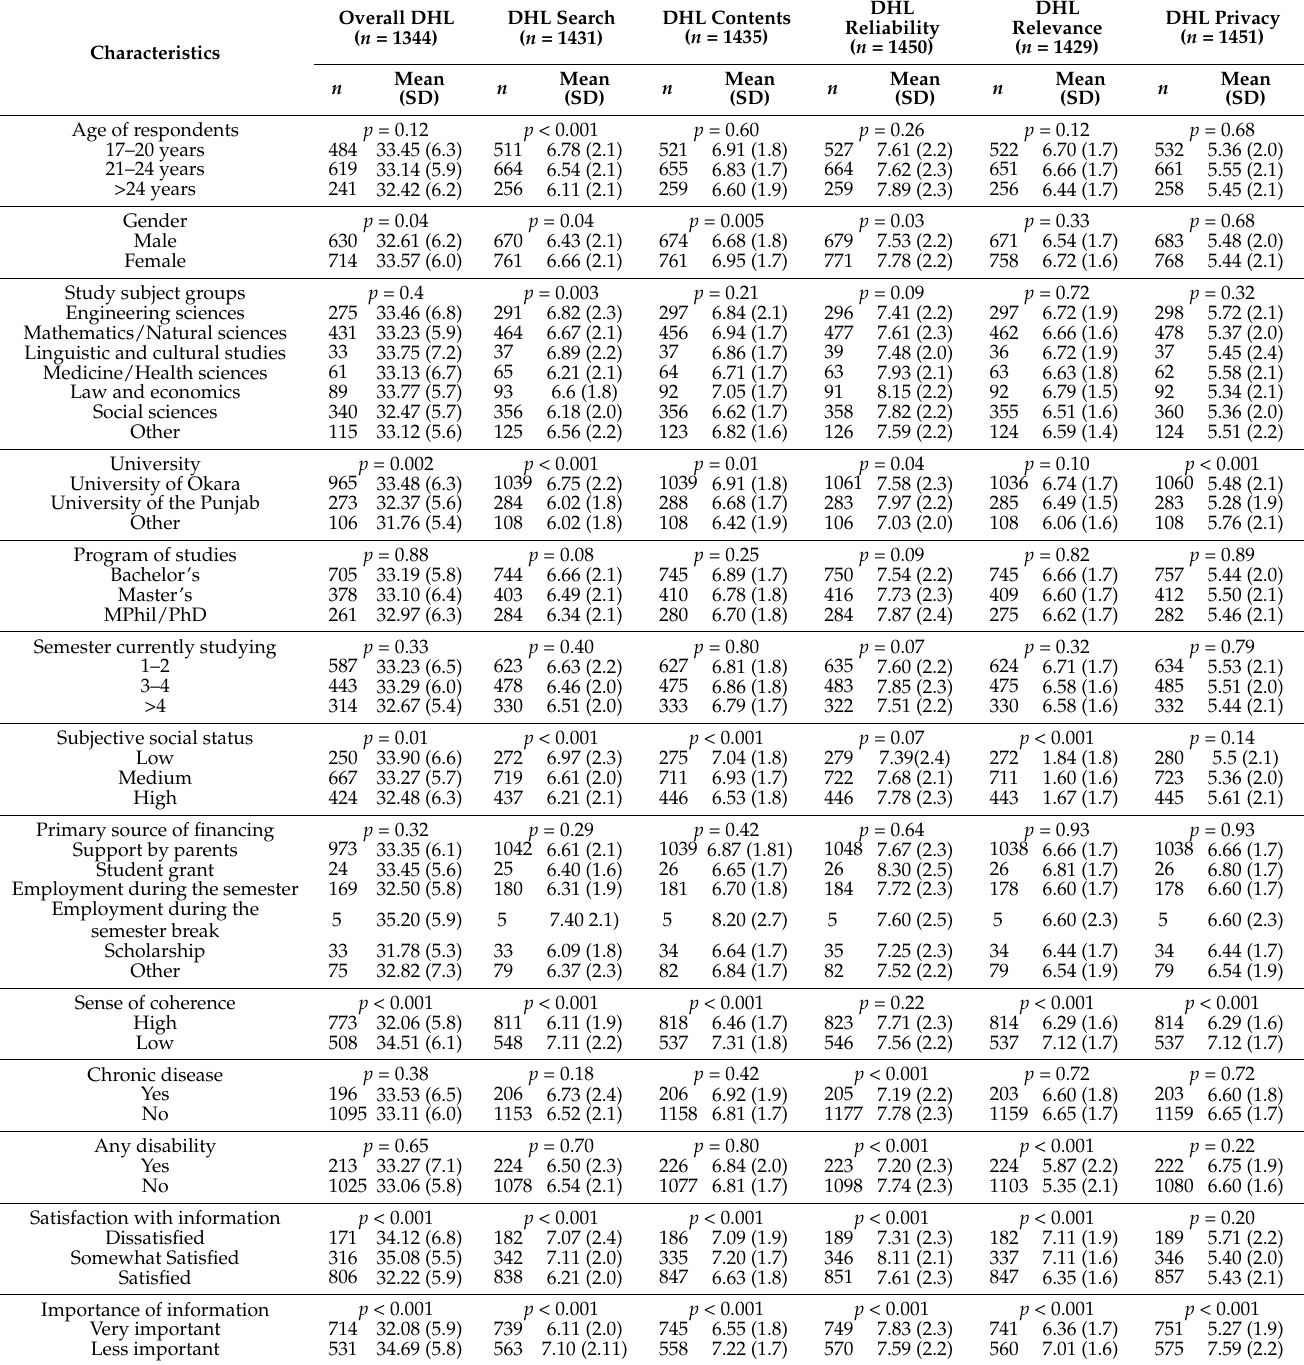
Table 7. Relationship between respondents’ characteristics and digital health